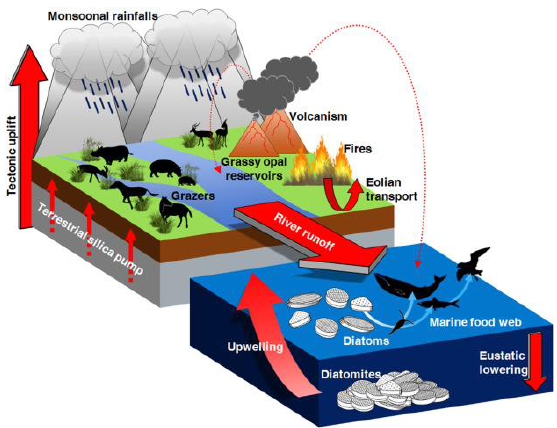
Figure 2. The diatomite deposition in the Mediterranean region. Reprint with permission from [51].